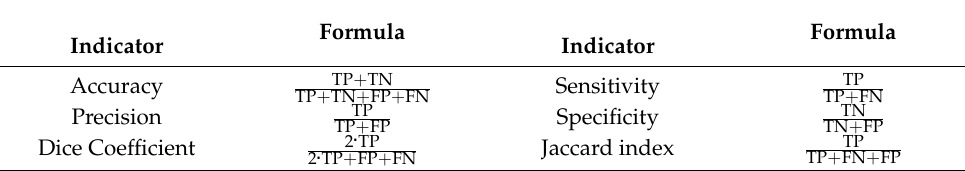
Table 1. Performance indicators used in the